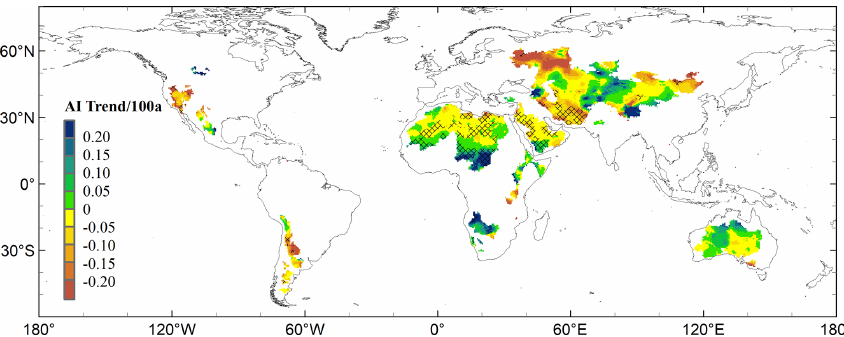
Figure 3. Linear trends of modern observational AI for the period of 1979–2016 in global closed basins. Gridded areas are where the trends are statistically significant at 5% level. Table 3. Pearson correlation coefficients between annual AI and monthly MEI during 1979–2016. The bold numbers mean that correlation